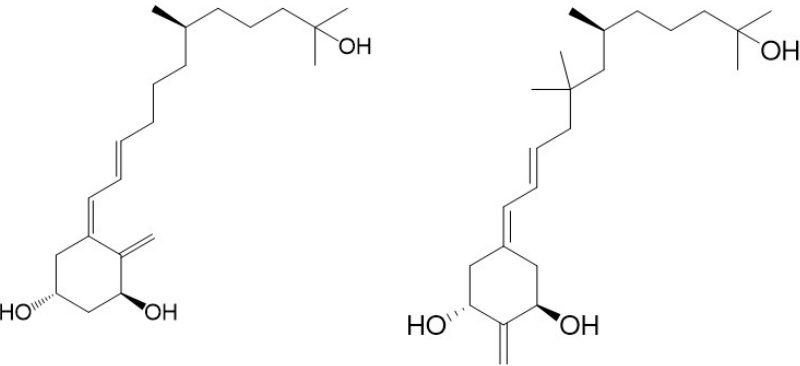
Figure 2. The structure of RAD 2 , the first des -C,D analogue of 1 α ,25-dihydroxyvitamin D 3 and of (20 S )-13,13-dimethyl- des -C,D-1,25-dihydroxy-2-methylene-19- nor -vitamin D 3